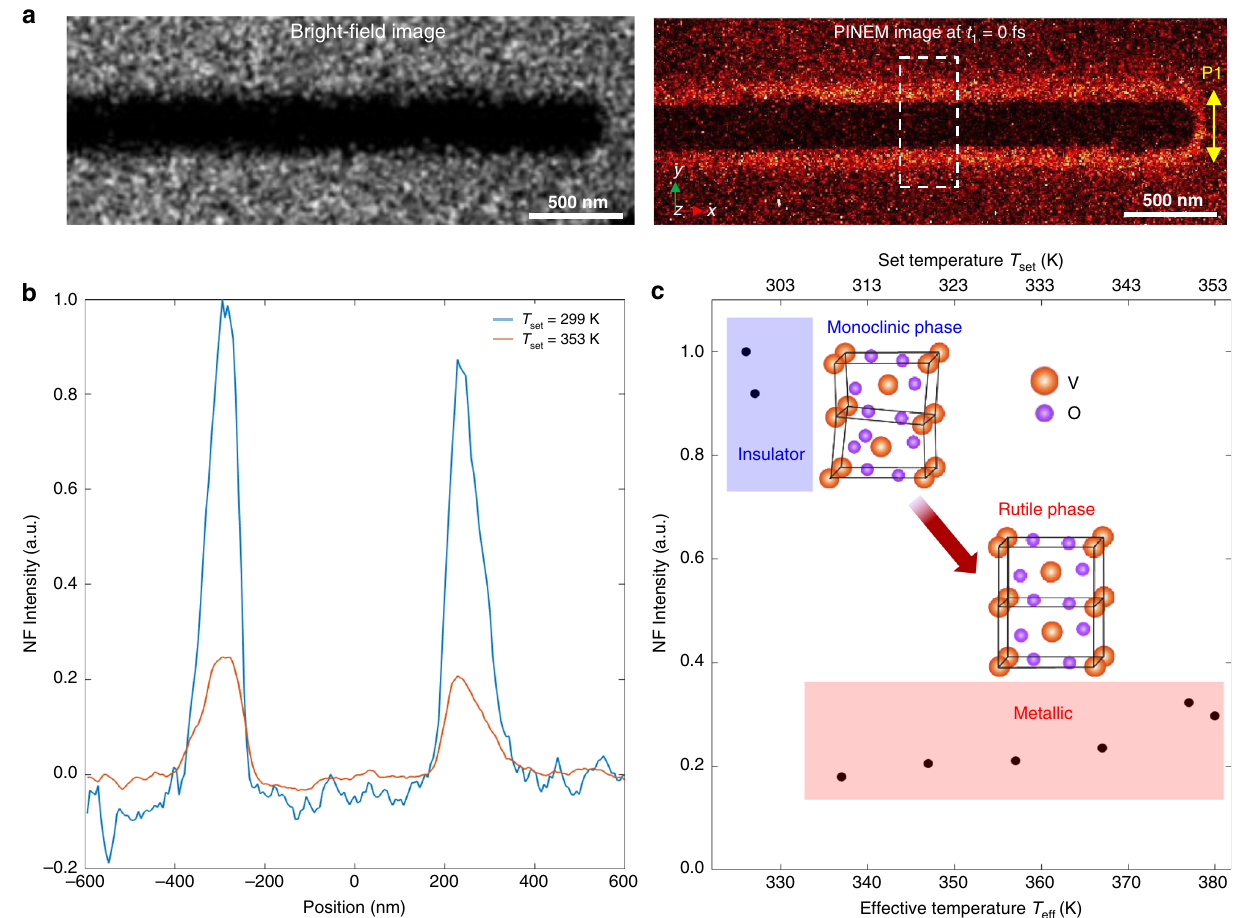
Fig. 2 One-color PINEM experimental result of a single VO 2 NW at different temperatures. a Left panel: bright- fi eld image; right panel: typical energy- fi ltered PINEM image ( t = 0 fs) of the investigated VO 1 2 NW (~350 nm in diameter) with the P1 optical pulse polarized perpendicularly to the NW axis. b Spatial distribution of the PINEM signal across the NW at T set = 299K (blue line, below transition) and T set = 353 K (orange line, above transition). The intensity was integrated along the NW axis in the area indicated by the dashed white box in the PINEM image shown in the right panel of a . The middle plane of the NW along the y direction is de fi ned as zero for the positions in the horizontal axis. For this one-color PINEM measurement, 800 nm optical pulses ( fl uence of ~4.1 mJ/cm 2 ) were used and the time delay was set at t 1 = 0 fs to maximize the PINEM coupling. c Integrated PINEM intensity of the NW as a function of temperature. T set is the set temperature of the sample on the heating holder, and T eff is the effective temperature, which differs from the T set due to an additional temperature jump (~31 K) induced by the 800 nm optical pulse (P1). The PINEM intensity in the vicinity of the VO 2 NW signi fi cantly decreases when raising the temperature above the transition point (~340 K). The insets show the lattice structures of insulating monoclinic phase and metallic rutile phase,